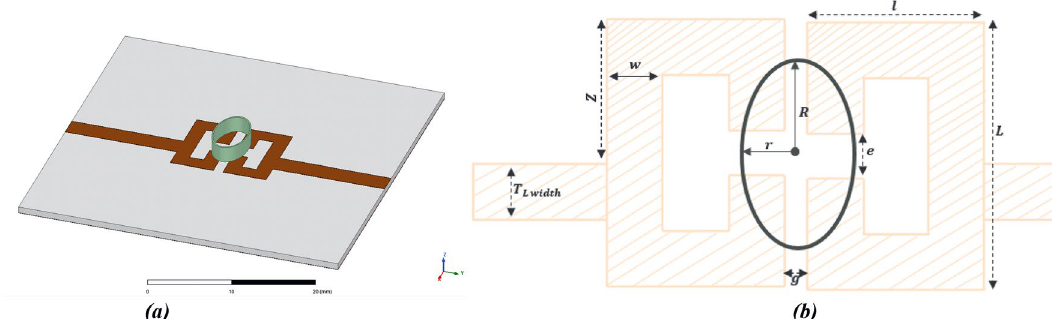
Figure 9. ( a ) 3D model and ( b ) layout of the designed sensor.